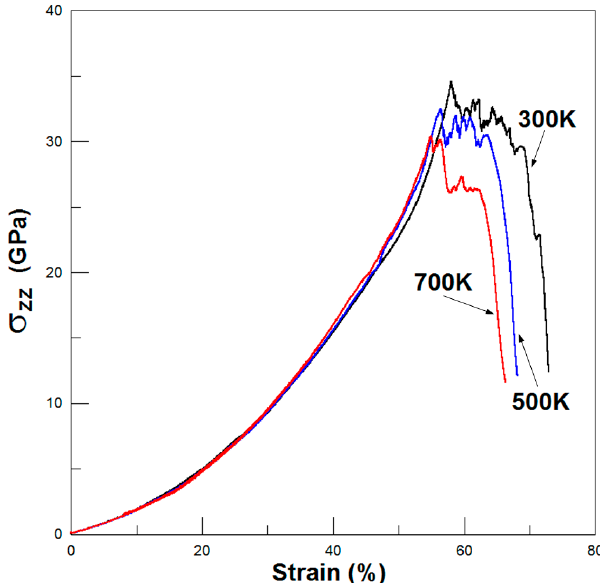
Figure 19. Axial stress-strain curves.